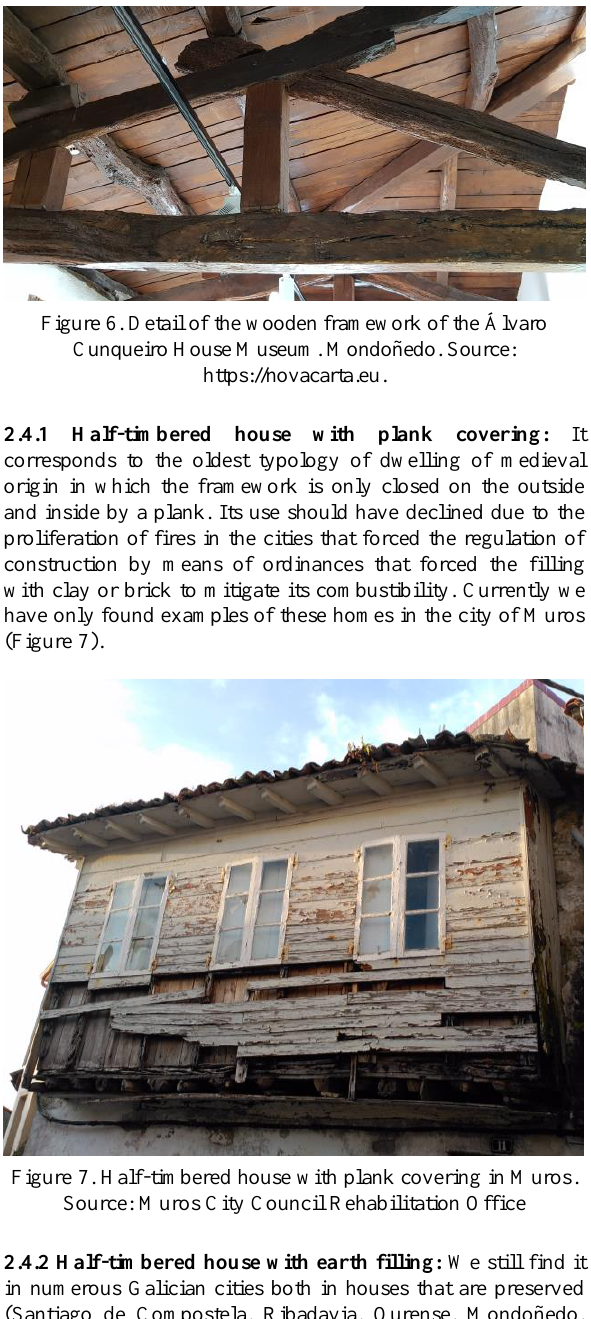
their construction materials.